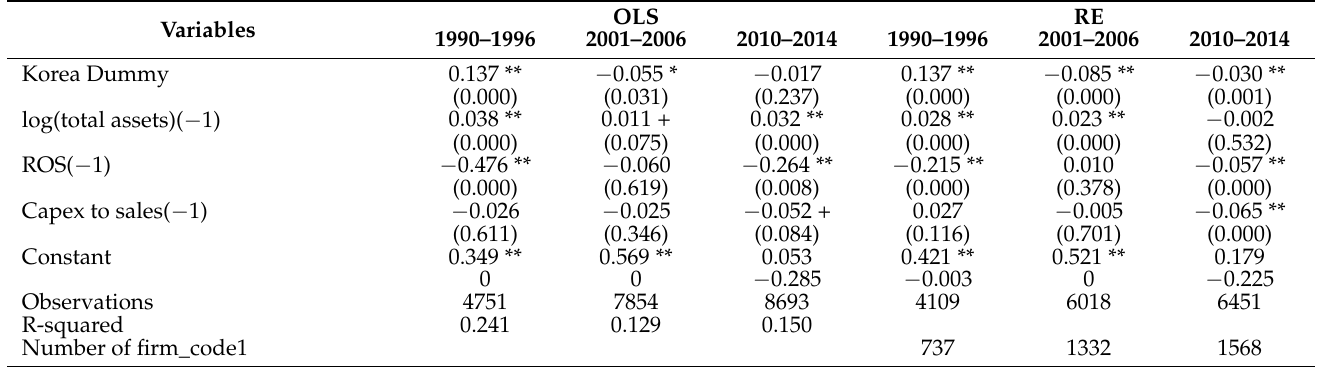
Table 3. Comparison of debt ratio by regression.